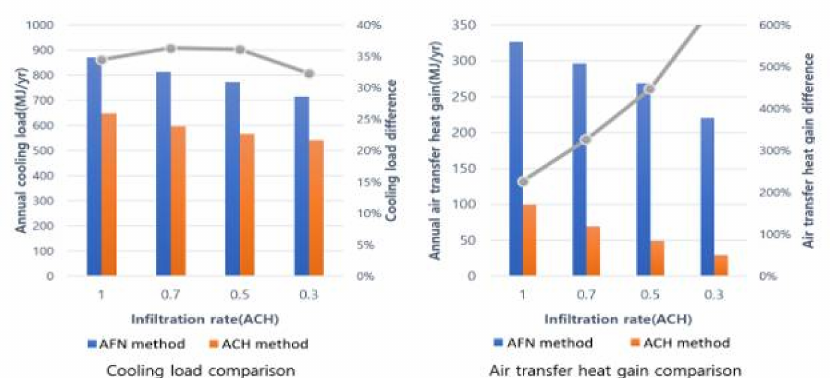
Figure 11. Comparison of the AFN model and the ACH model when used to describe annual cooling load and air transfer heat gain in parametric analysis